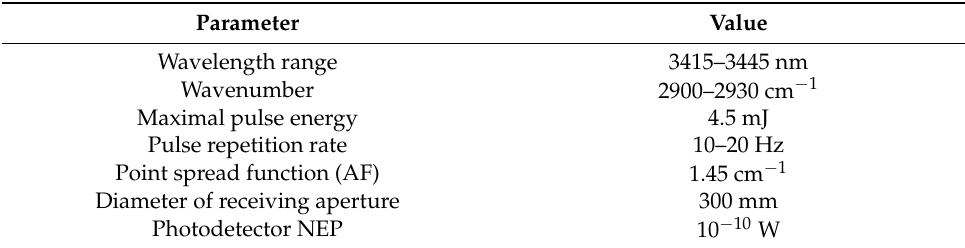
Table 3. Input data for simulation of airborne lidar